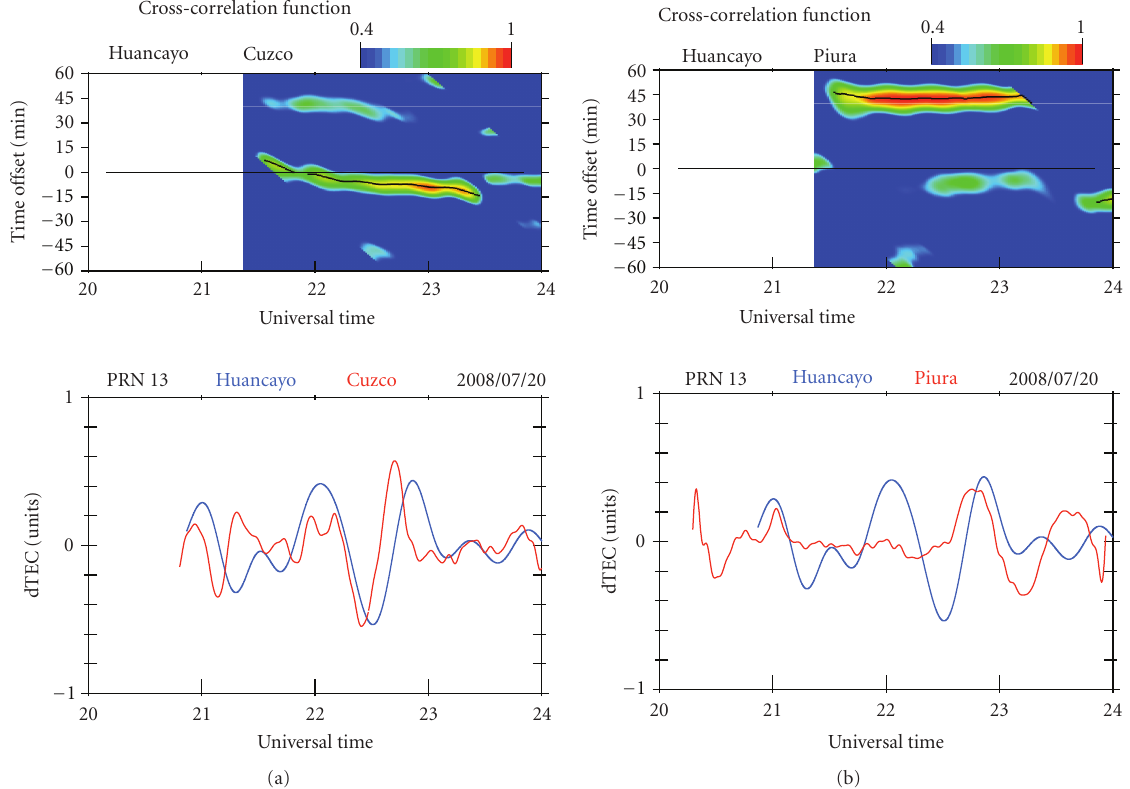
Figure 9: Same as Figure 6, but for CCF between Huancayo and Cuzco on the left side and Huancayo and Piura on the right side.